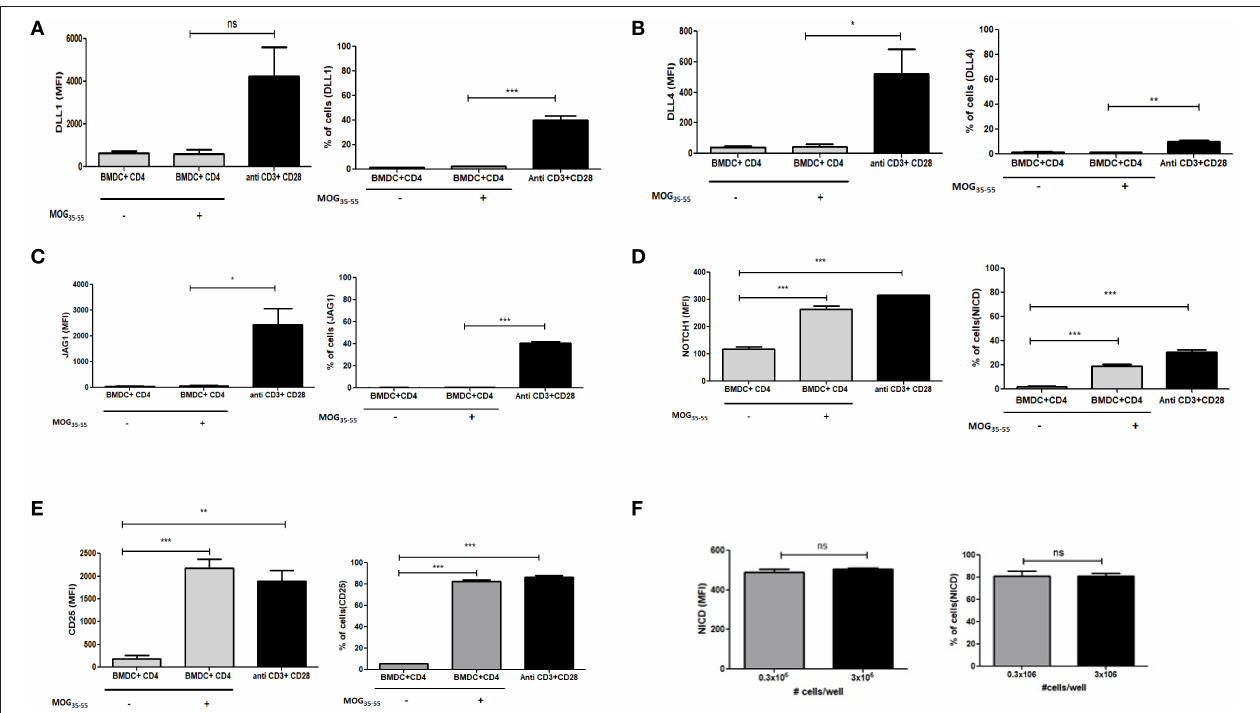
FIGURE 2 | Notch ligands are not expressed on CD4 T cells in the presence of APCs but Notch1 is activated. CD4T cells from 2D2 Transgenic mice were cocultured with MOG 35 − 55 pulsed mature bone marrow derived dendritic cells (BMDC) obtained from 2D2 mice. T cells were stained with CFSE and BMDCs with Cell trace violet cell tracker dye before setting up for coculture. CD4T cells stimulated with anti CD3 ε or anti CD28 or anti CD3 ε and anti-CD28, at 1 µ g/mL each was activated along with the coculture. Cells harvested after 6h and analyzed by flow cytometry for ligands and N1ICD and after 24h for CD25. Analysis is done by gating on CFSE positive T cells and cell trace violet positive BMDCs. MFI values and percentage of positive cells for the indicated proteins for indicated treatments were plotted for (A) DLL1, (B) DLL4, (C) JAG1, (D) Intracellular cleaved Notch1 (N1ICD), and (E) CD25 on CD4T cells. (F) MFI values and percentage of positive cells with intracellular Notch in CD4T cells after 24h of activation. CD4T cells from C57BL/6 mice were stimulated with soluble anti-CD3 ε and anti-CD28 at 1 µ g/mL at a concentration of 0.3 × 10 6 or 3 × 10 6 for 24h. Cells were harvested after 24h and intracellularly stained for Notch1 ICD. Data represent three independent experiments. Data represent mean ± SEM. * p < 0.05, ** p < 0.005, and *** p < 0.001. ns, not